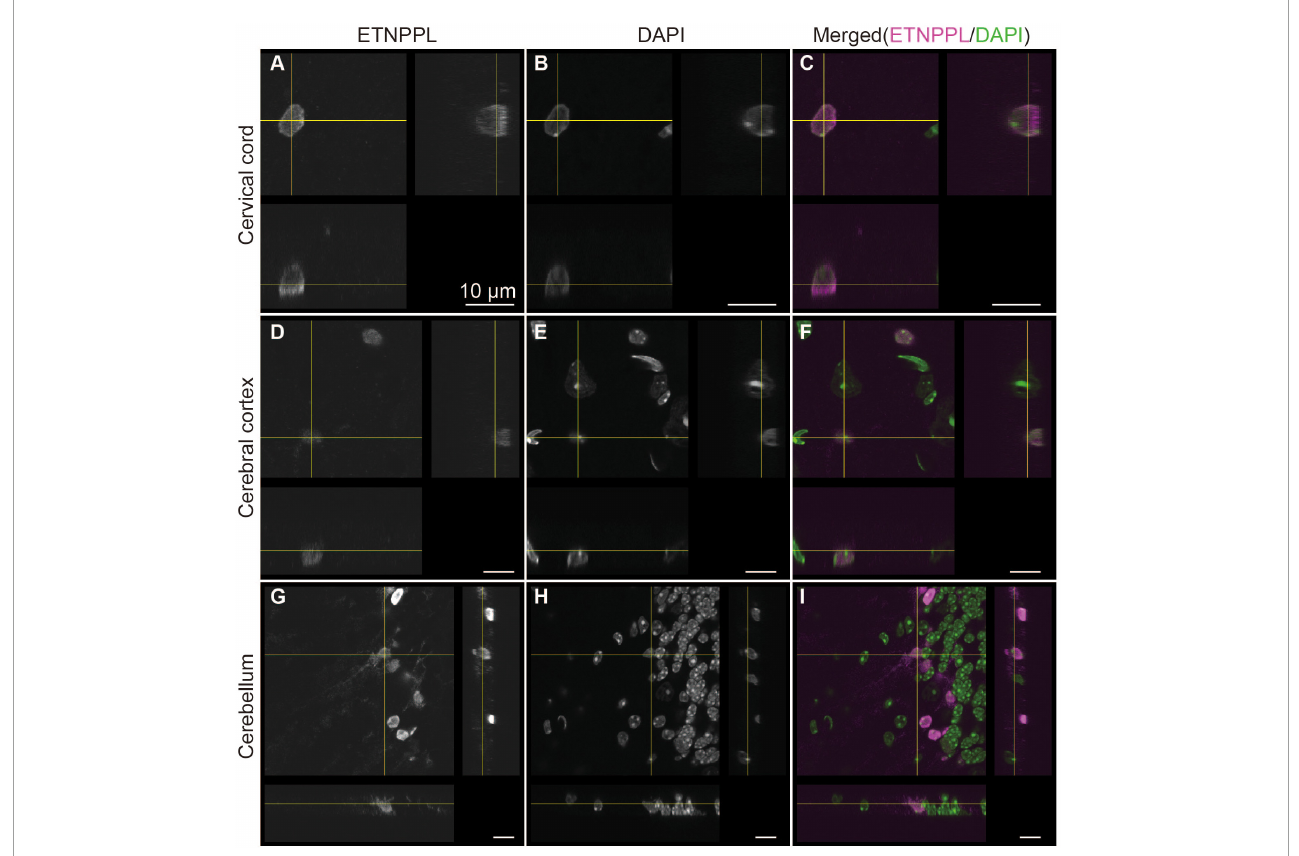
FIGURE7 Subcellular localization of ETNPPL. Confocal orthogonal images of ETNPPL-expressing cells in the cervical cord (A–C) , cerebral cortex (D–F) , and cerebellum (G–I) in Figure 6 are shown. Signals for ETNPPL (A,D,G) or nuclear staining with DAPI (B,E,H) are shown. Merged images (magenta indicates ETNPPL and green indicates DAPI signal) are shown in (C,F,I) . Scale bars: 10 µ